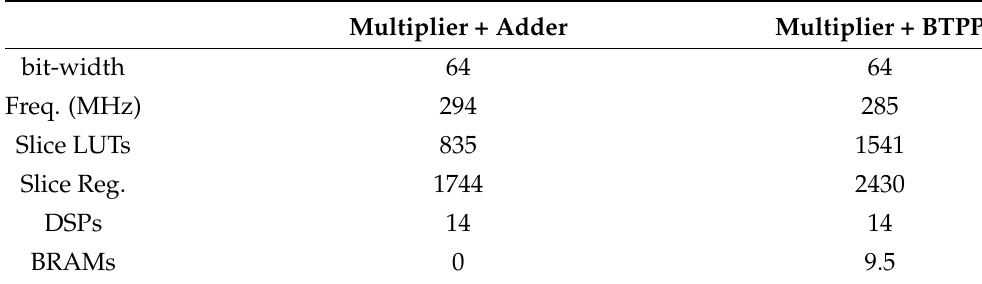
Table 3. Two circuits for matrix-vector multiplication are implemented on Xilinx Artix-7 XC7A100T.